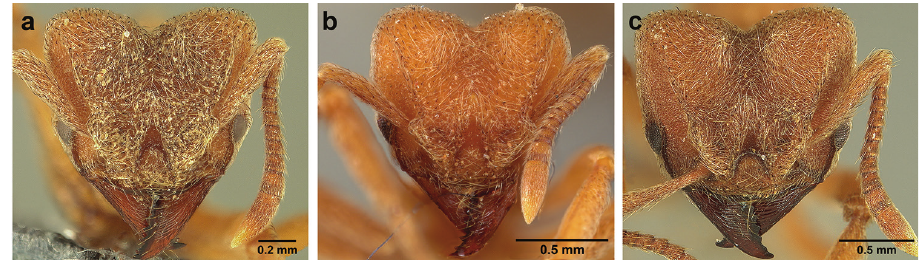
Figure 16. S. saussurei , S. amabilis , and S. mayri . a S. saussurei head, full-face view b S. amabilis head, full-face view c S. mayri head, full-face